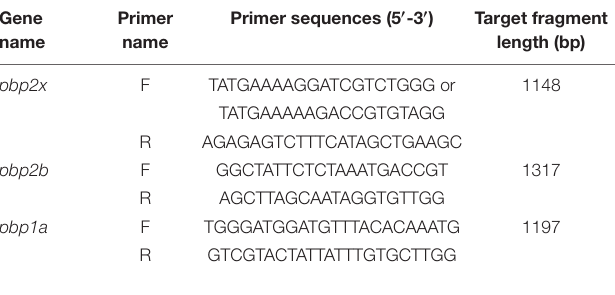
TABLE 1 | Primers for amplification and sequencing for the region encoding the penicillin-binding domain of pbp2x , pbp2b and pbp1a genes.